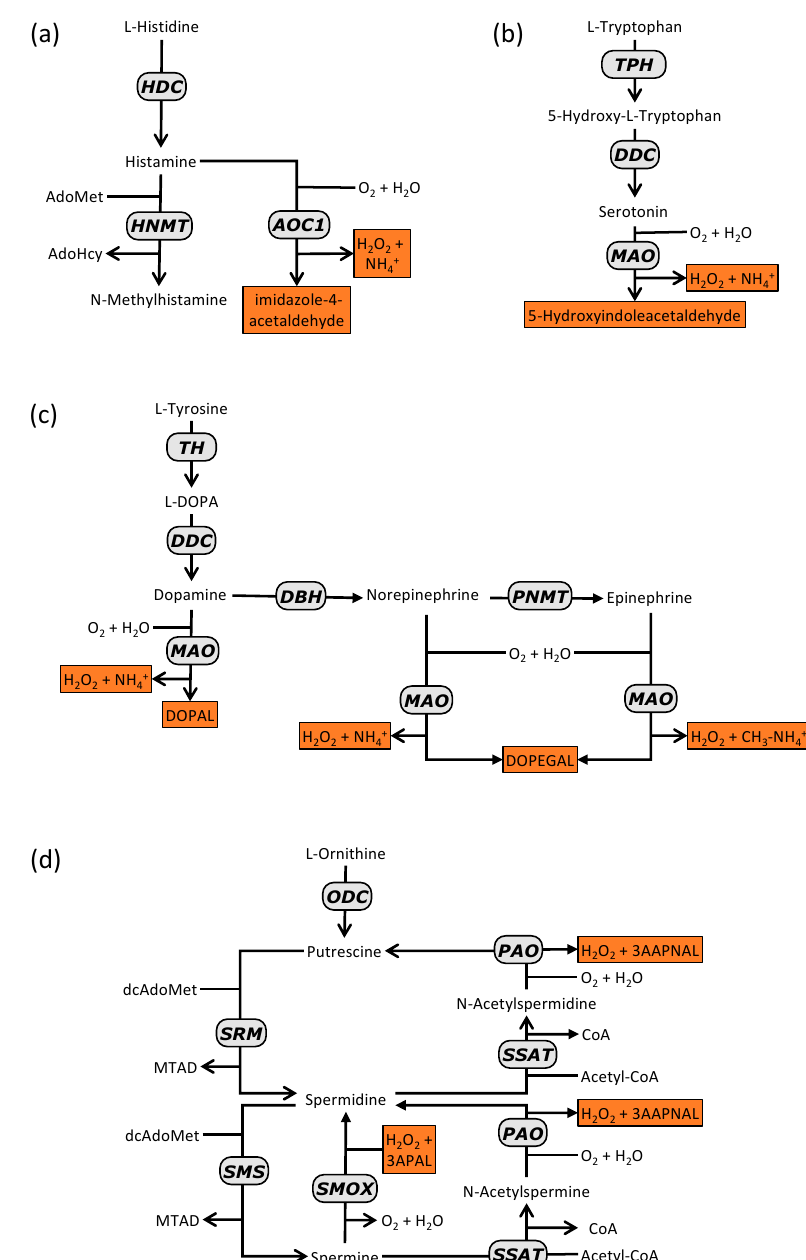
Figure 2. Aromatic and cationic BA synthesis and degradation pathways in mammalian cells. ( a ) histamine; ( b ) serotonin; ( c ) cathecolamines; ( d ) polyamines. Degradation products are depicted in orange boxes. Abbreviations (by alphabetical order): AdoMet, adenosylmethionine; AdoHcy,